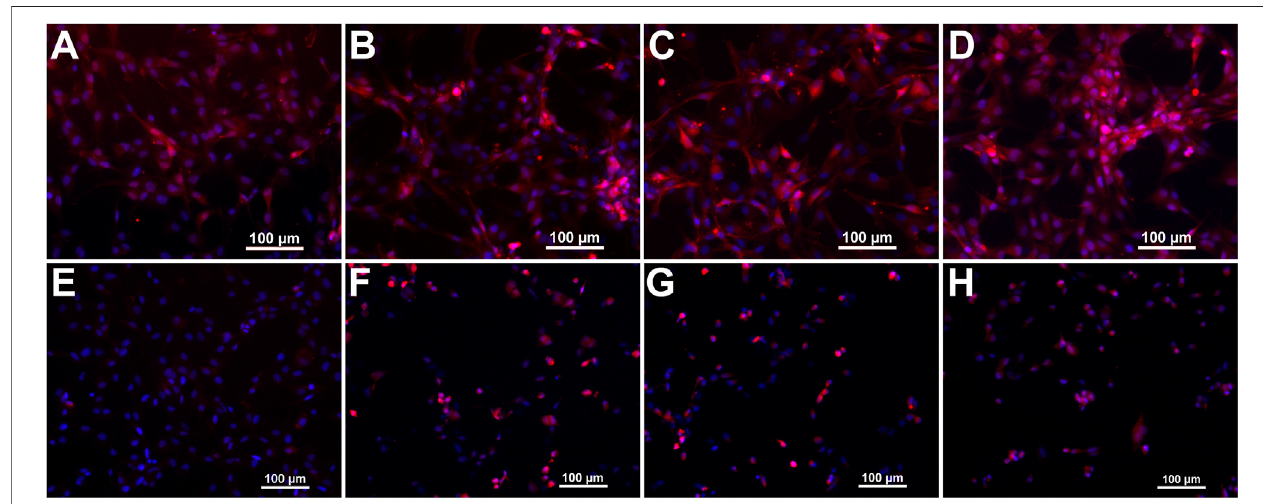
FIGURE5| MicroscopicimagesofU87MGcellsstainedwiththedeveloped fl uorescentprobes.Panels (A – D) showmerged fl uorescenceimagesfromCy5.5and DAPI channels of probes 2 – 5 , respectively. Panels (E – H) show cells from control experiments after blocking integrin α v β 3 with an excess of cilengitide.